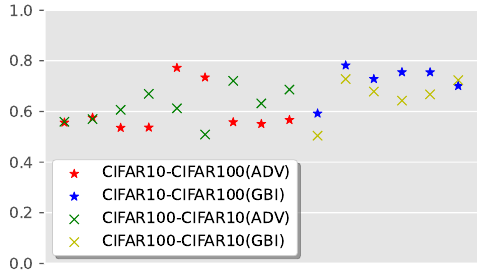
Figure 3. The generalizability for